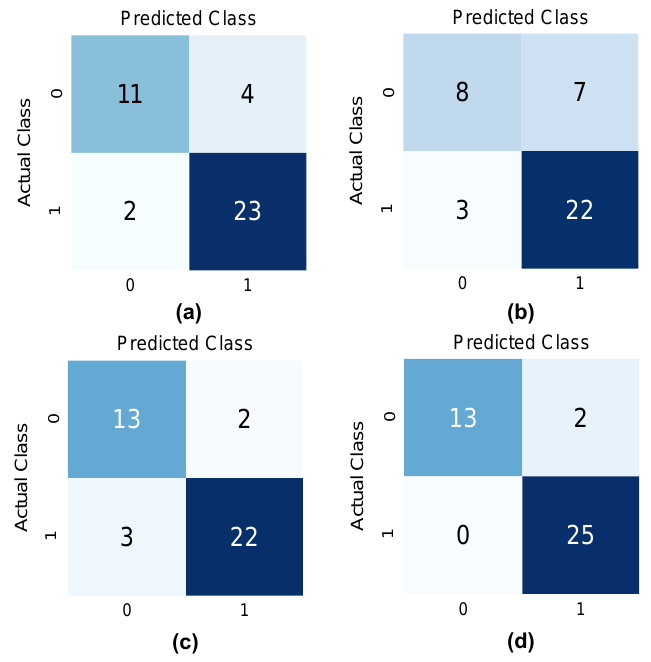
Figure 13. Confusion matrices: ( a ) the radiomics feature and patient data-based model; ( b ) the single image-based model; ( c ) the multi-patch-based model; and ( d ) the proposed framework.